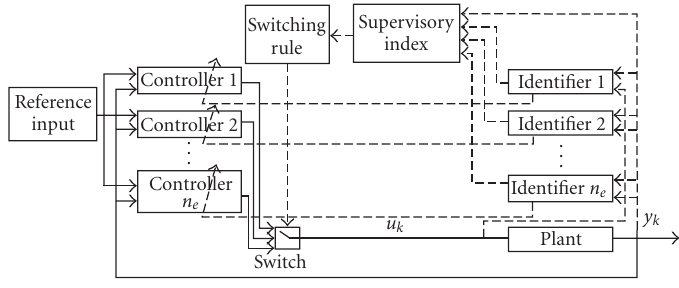
Figure 2.3. Multiestimation